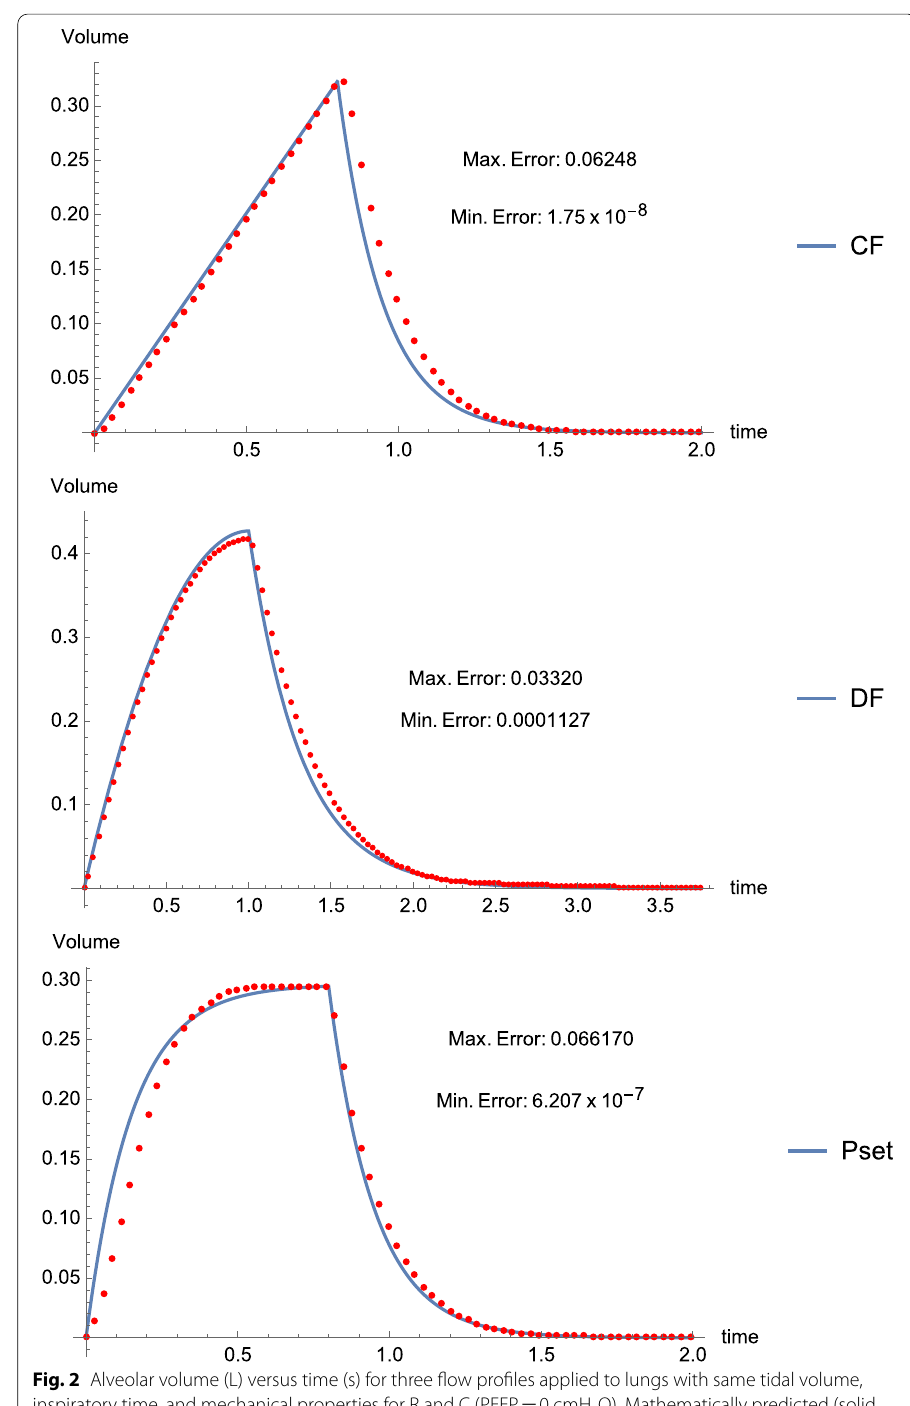
Fig. 2 Alveolar volume (L) versus time (s) for three flow profiles applied to lungs with same tidal volume, inspiratory time, and mechanical properties for R and C (PEEP 0 cmH 2 O). Mathematically predicted (solid = line) and physically observed (dotted line) quantities agreed particularly closely for the inflation phase of the flow-controlled modes (constant [CF] and decelerating [DF]). Inflation by the mechanical simulator lagged slightly in response to P set inflation, due to the ventilator’s ‘ramped’ early pressurization